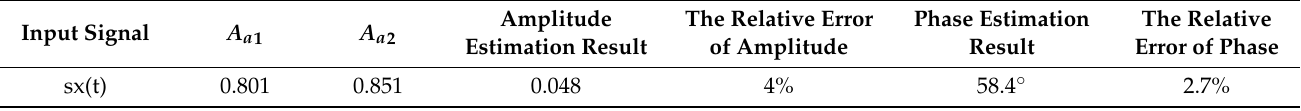
Table 2. Estimation results of the amplitude and phase of the useful